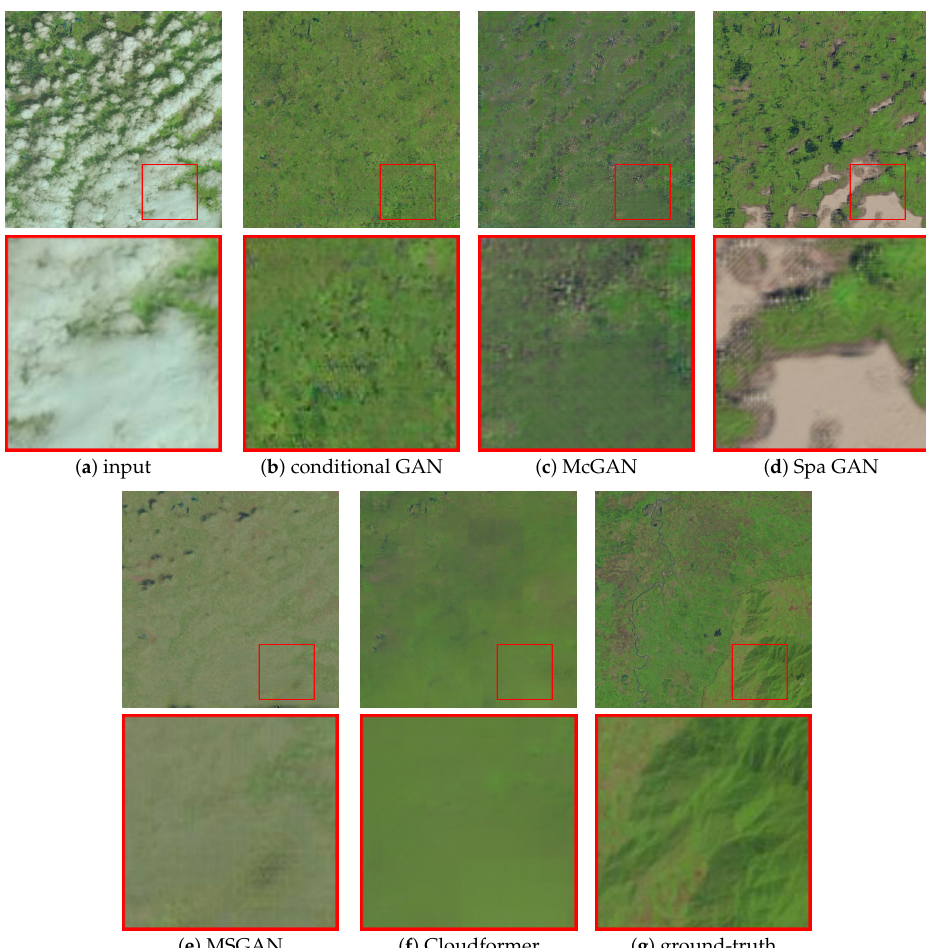
Figure 13. Comparative experimental results on the third sample of RICE2. When most of the input image is covered by cloud, McGAN, Spa GAN and MSGAN can only preserve color well near areas not obscured by cloud and show a wide range of color distortions in other areas. Conditional GAN produces black patches that destroy image continuity. Relying on only a few cloud-free areas, our method recovers the color information of the entire image as much as possible and maintains image